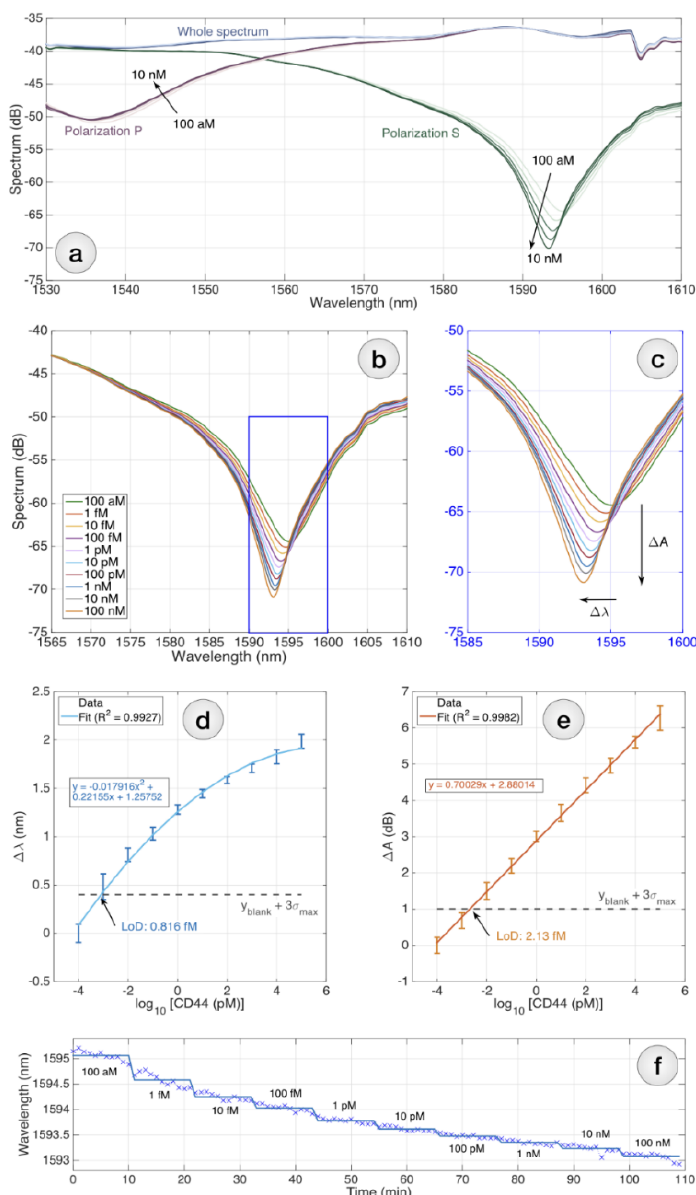
Figure 5. Detection of CD44 using the biofunctionalized sensor: ( a ) reflective spectrum of the biosensor; ( b ) the S-polarization spectrum is chosen for interrogation; ( c ) the inset shows the spectral portion in correspondence to the main dip; interrogation can be performed by tracking either the intensity change ΔA or the wavelength shift Δλ; ( d , e ) CD44 protein detection charts, reporting the wavelength shift ( d ) and the intensity change ( e ); ( f ) sensorgram for the CD44 detection, reporting the instantaneous wavelength (markers) and average (solid lines) over 109 min with 1-min sampling.